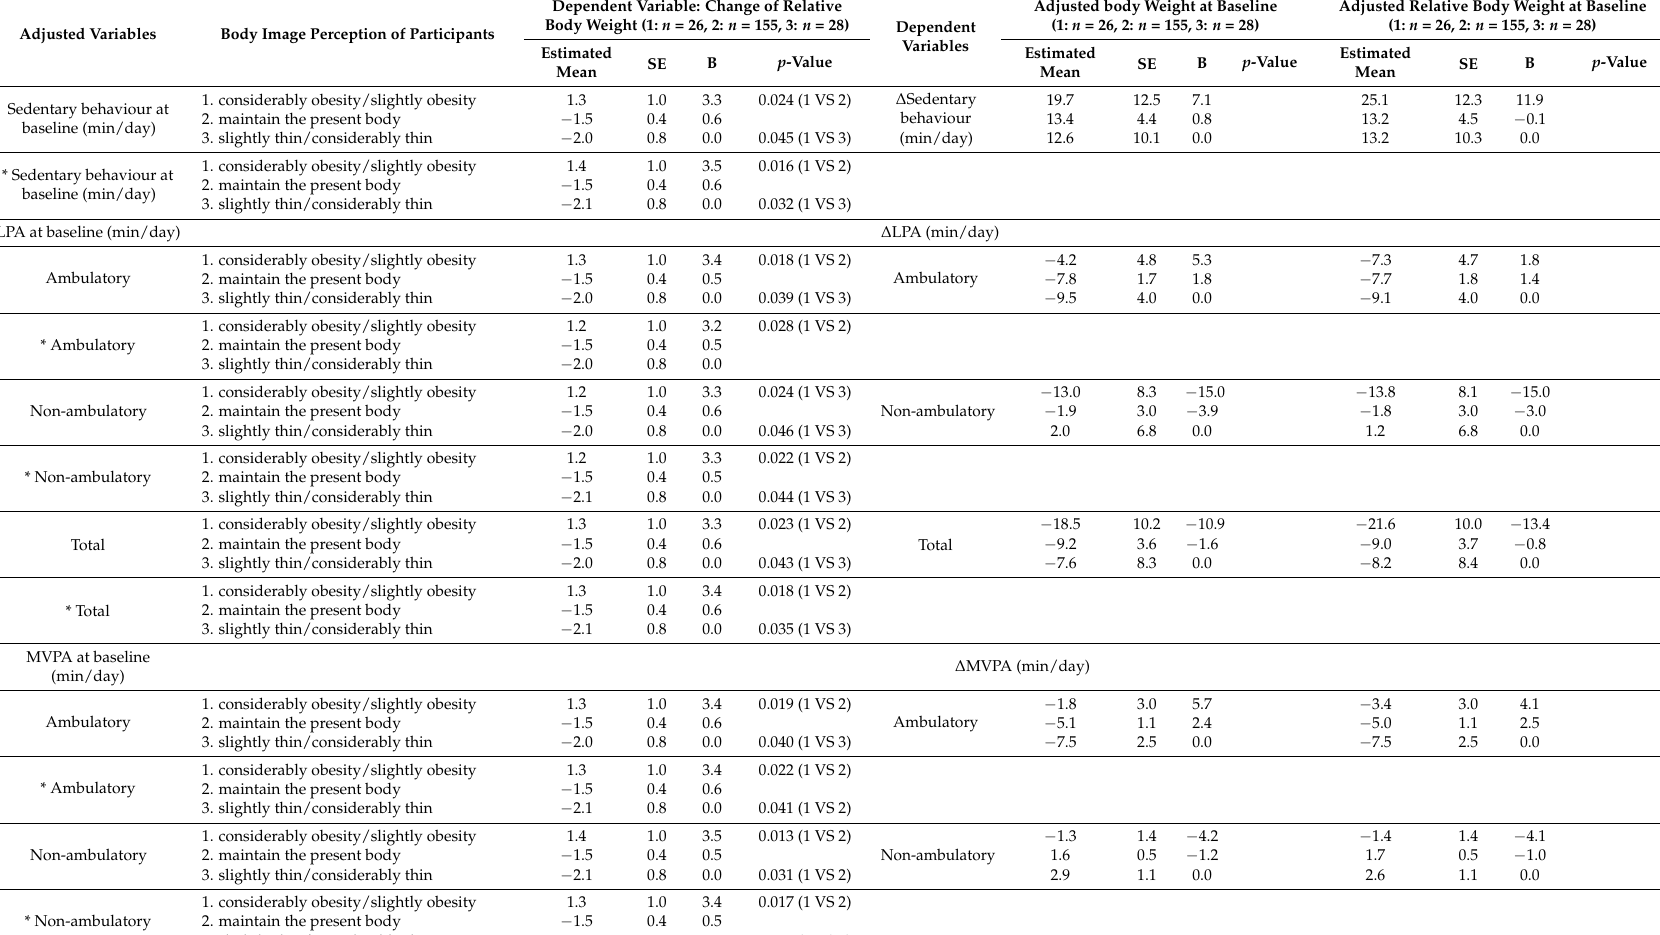
Table 4. Associations between change of relative weight and body image at